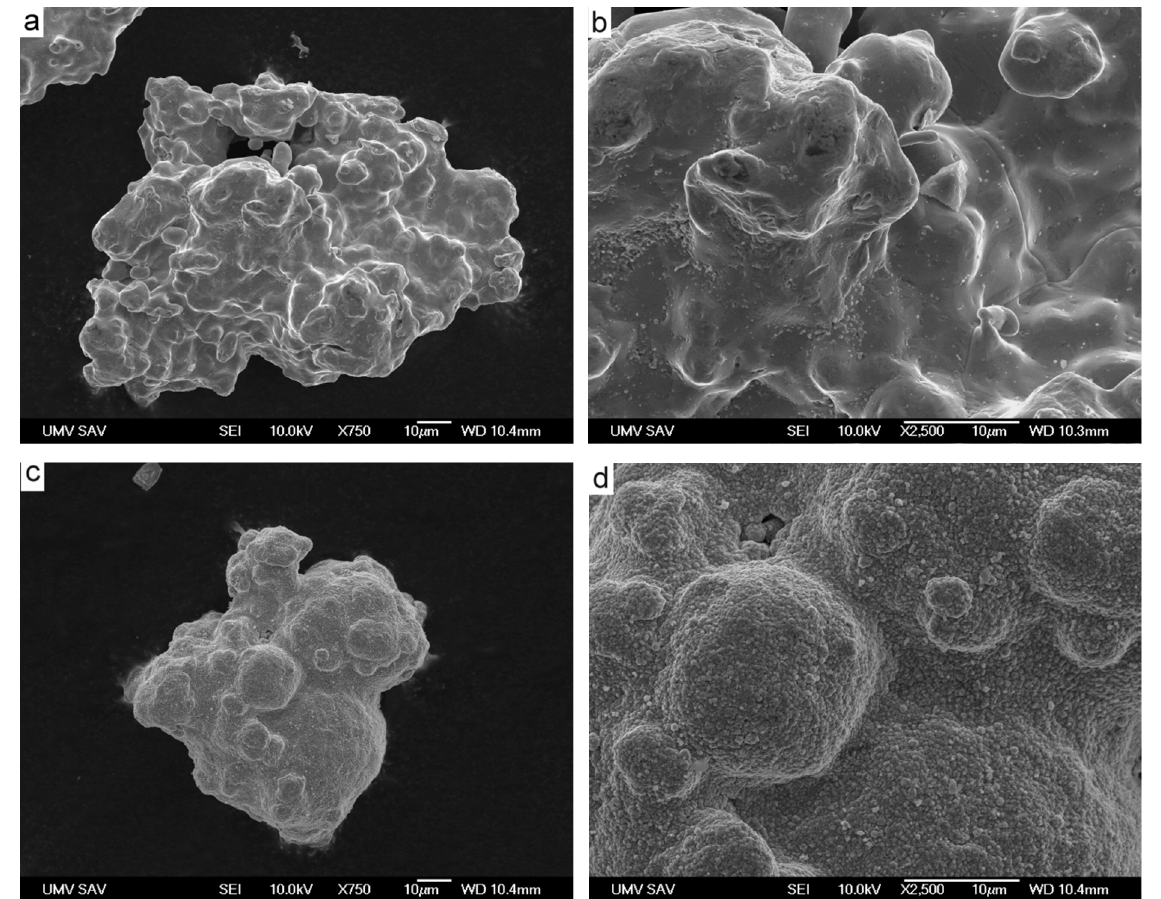
Figure 1. Typical bare ( a , b ) and copper-coated ( c , d ) particles of water-atomized iron powder (ASC 100.29, Höganäs AB). The content of copper in presented powders is 0 wt.% ( a , b ) and 8 wt.% ( c , d ), SEM.